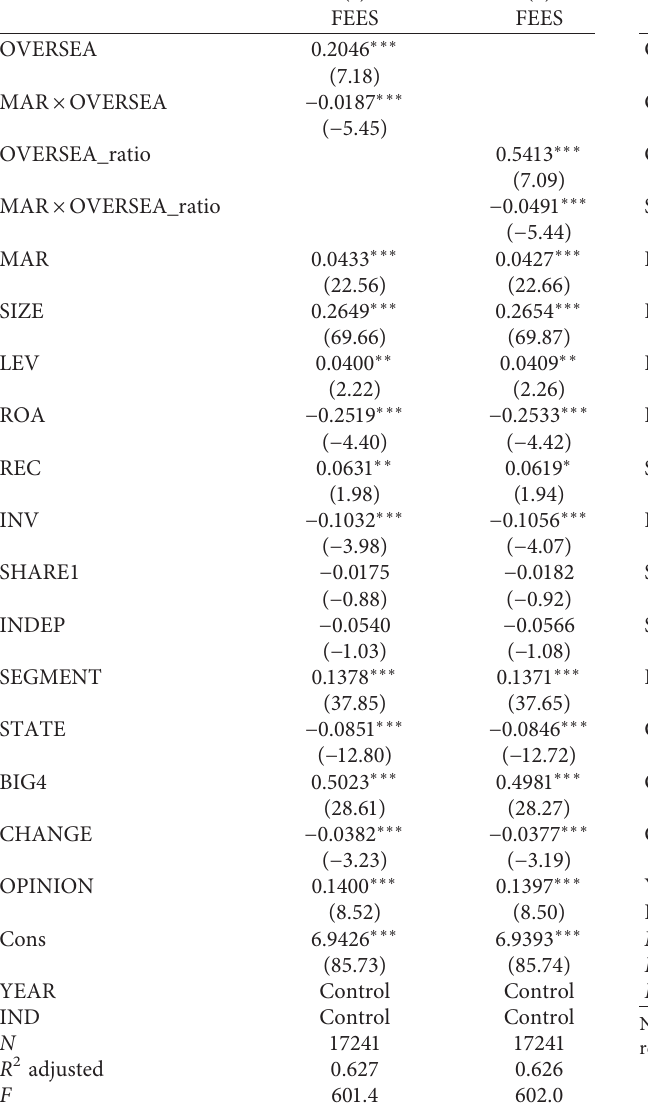
Table 9: Audit committee overseas working experience, learning experience, and audit